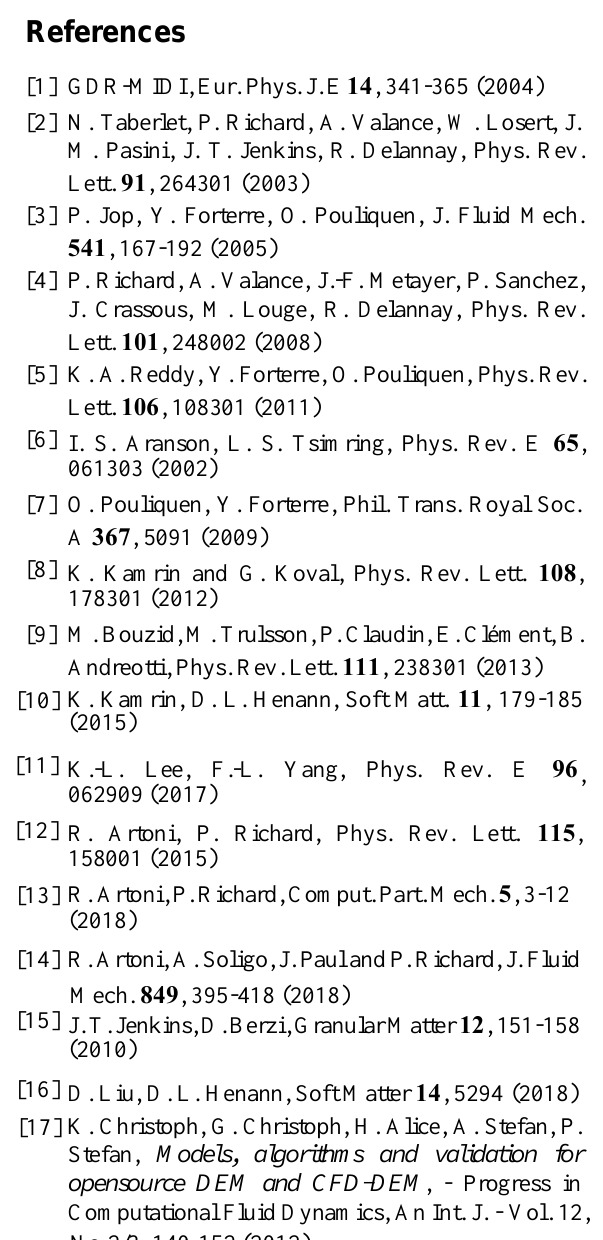
μ c =0.38 is chosen and l / d =0.79 is an averaged fitted